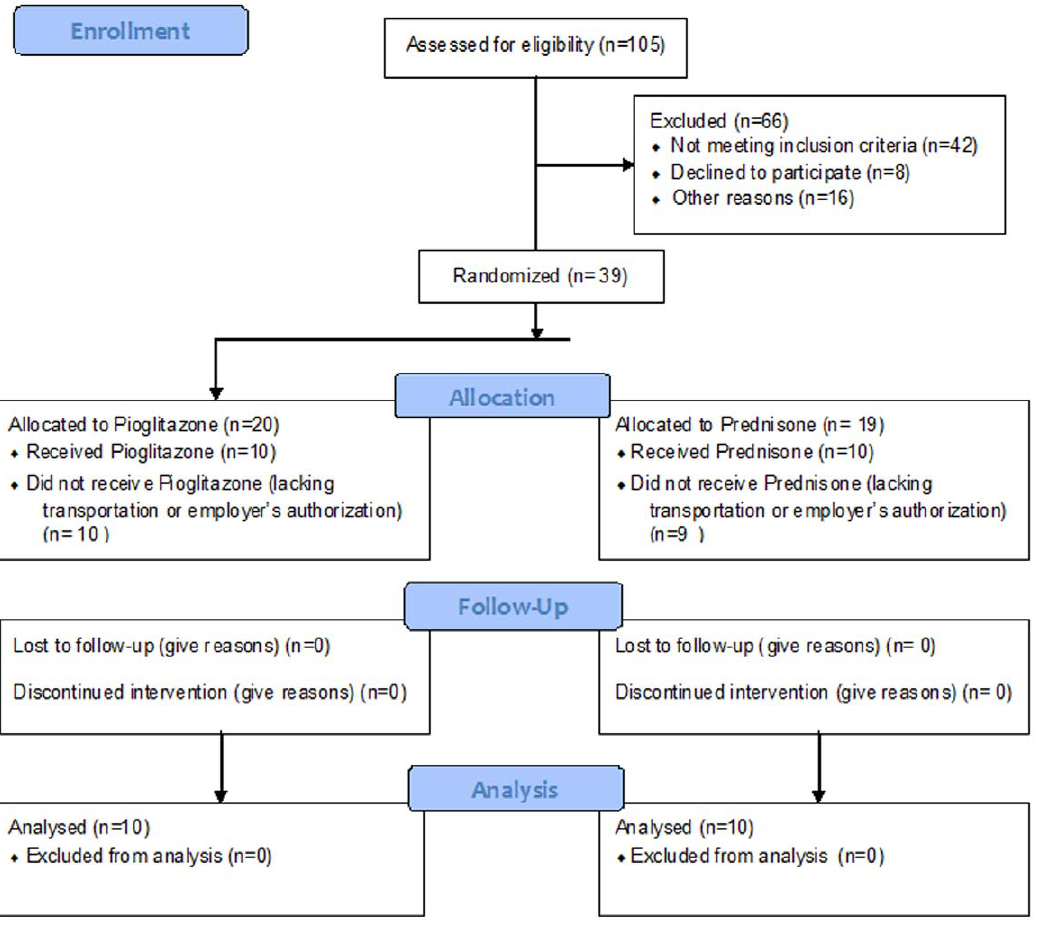
Figure 1. Participant Flow. Patients with chronic Hepatitis C genotype 4 referred to the Hepatology Clinic were assessed for eligibility as described in Methods.